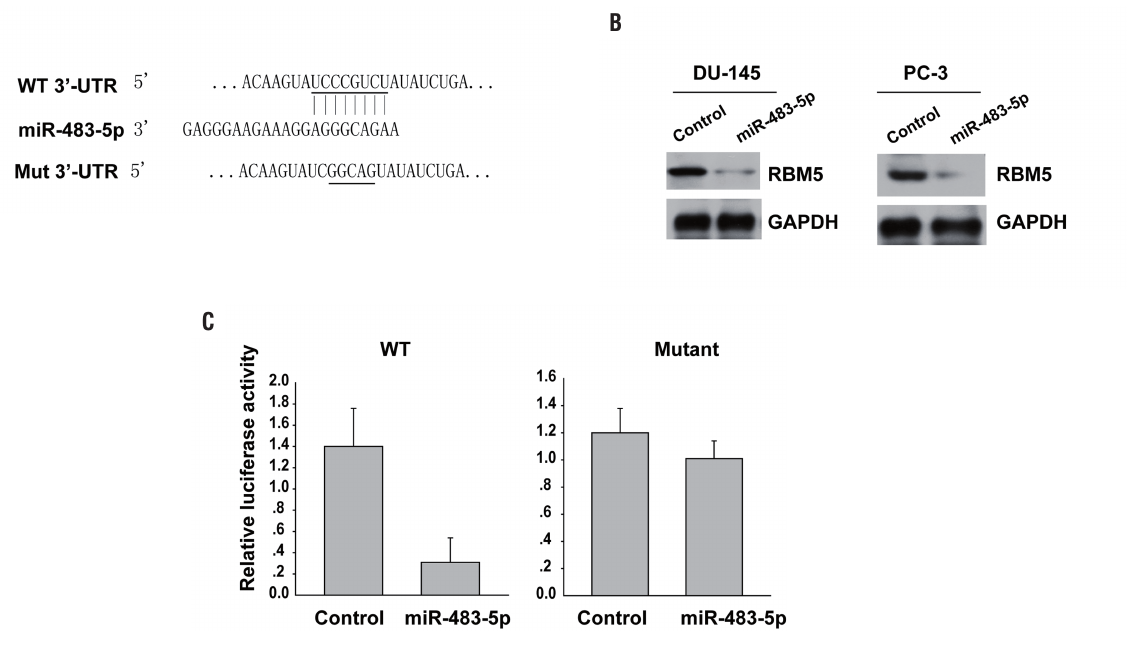
Data are presented as mean±SD from three independent